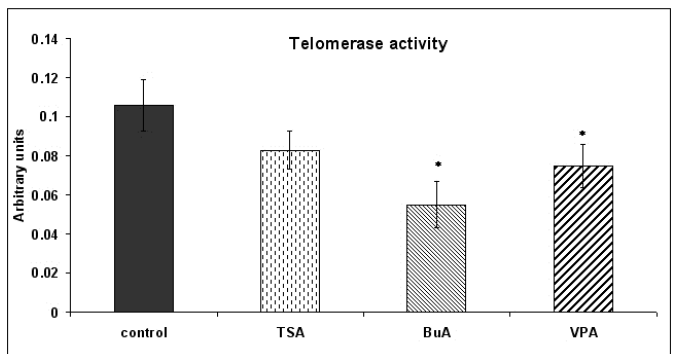
Figure 1. Telomerase activity in the presence of histone deacetylases (HDAC) inhibitors. All three inhibitors: Butyrate (BuA) (2 mM), Valproic acid (VPA) (0.5 mM) and Trichostatin A (TSA) (1 µM) decreased endothelial progenitors cells (EPCs) proliferation, significantly by BuA and VPA .Results are represented as mean ± standard error, n = 3, * p <